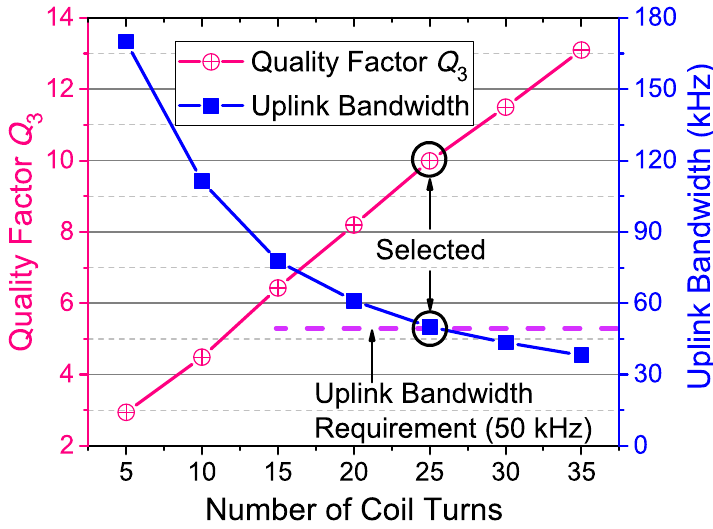
Figure 7. Measured quality factor of the external data coil and its bandwidth on the 500-kHz carrier versus the number of coil